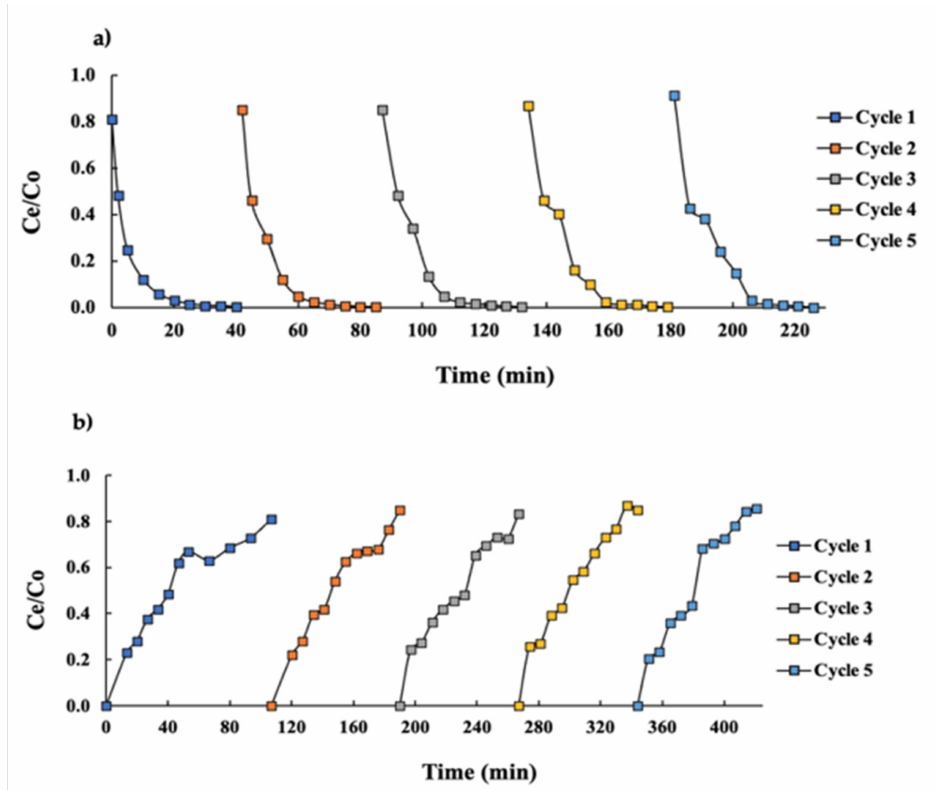
Figure 4. Sequences of cadmium desorption–regeneration–conversion–washing of the saturated column with the GSH solution at a 20.97 mg L − 1 cadmium concentration, pH of 6.2, and temperature of 55 ± 2 ◦ C. A backwash solution as a desorption agent was added at a flow rate of 0.1 L min − 1 . ( a ) Desorption of the cadmium process represented by 5 cycles. ( b ) Cycles of saturation of resin by cadmium from